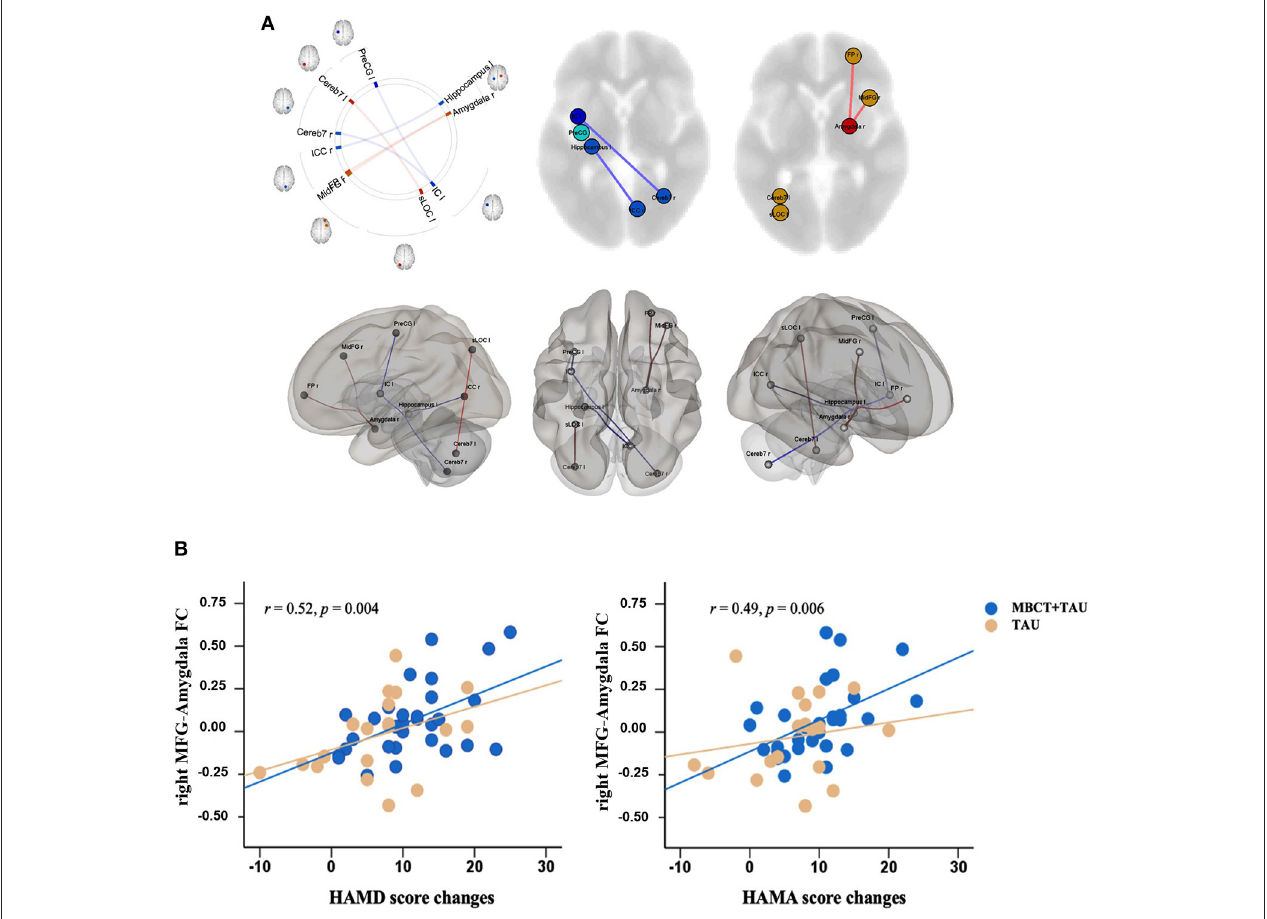
FIGURE 3 | Differences in changes in resting-state functional connectivity and correlations. (A) Difference in changes in resting-state functional connectivity in the two groups. (B) Correlation between resting-state functional connectivity and clinical measures.